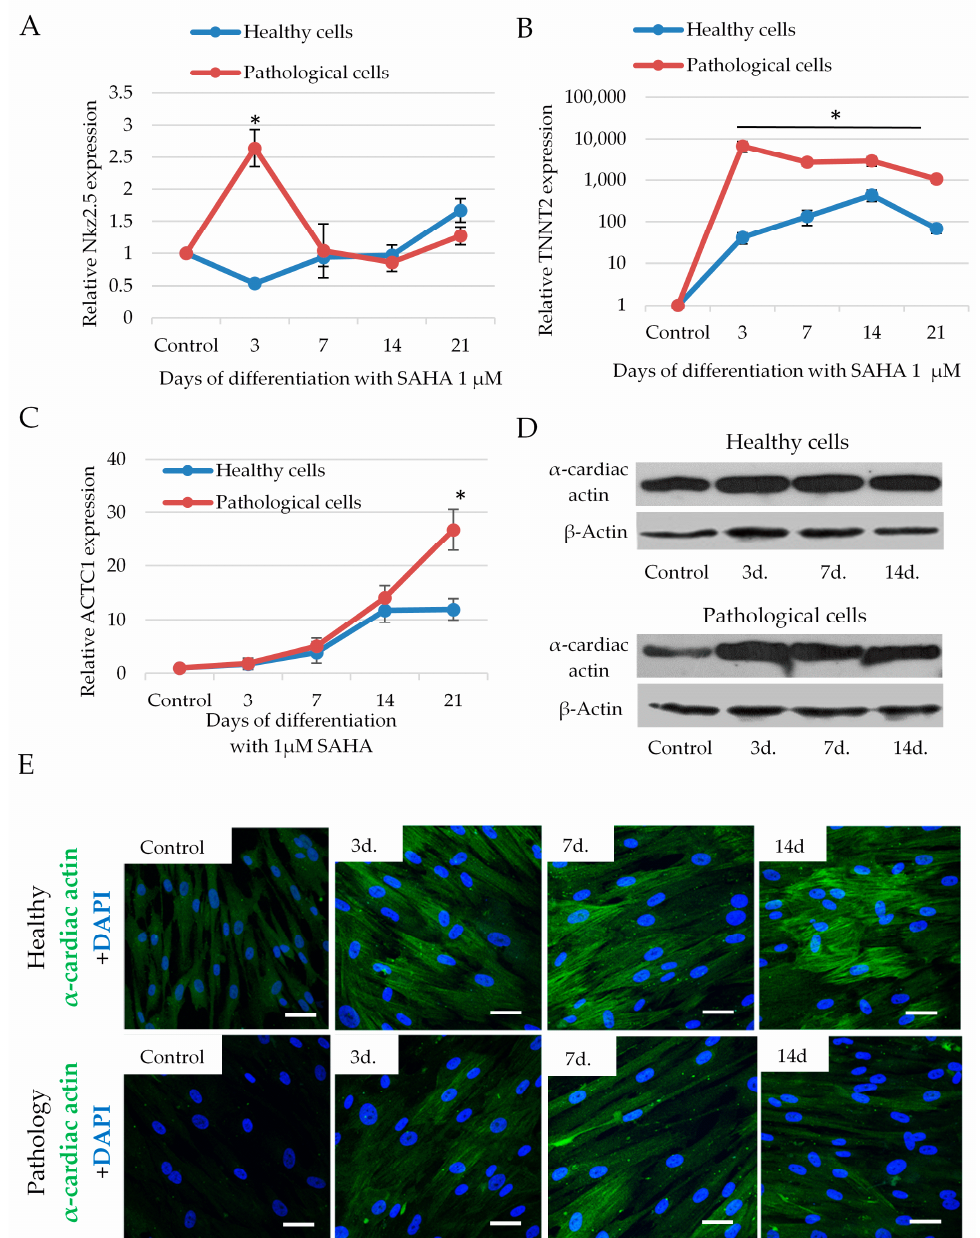
Figure 7. The impact of SAHA on the levels of transcription factor NK2 Homeobox 5 ( Nkx2.5 ), cardiac troponin T ( TNNT2 ) and alpha cardiac actin ( ACTC1 ), in healthy and pathological hmMSC. ( A ) Expression of Nkx2.5 gene (2 − ∆∆ CT ) in healthy and pathological cells during 3–21 days of cultivation with 1 µ M of SAHA. ( B ) Expression of TNNT2 gene (2 − ∆∆ CT ) in healthy and pathological cells during 3–21 days of cultivation with 1 µ M of SAHA. ( C ) Expression of ACTC1 gene (2 − ∆∆ CT ) in healthy and pathological cells during 3–21 days of cultivation with 1 µ M of SAHA. ( D ) Level of alpha cardiac actin protein compared to beta actin in healthy and pathological cells after exposure to 1 µ M of SAHA analyzed by Western blotting. ( E ) Immunocytochemical micrographs of alpha cardiac actin levels in healthy and pathological cells after exposure to 1 µ M of SAHA for 3–14 days, scale bar = 20 µ m. Control-healthy and pathological cells without SAHA. Gene expression was analyzed as follows: expression = 2 − ∆ Ct × 100,000, where ∆ Ct = (Ct target gene − Ct reference gene ); relative expression = 2 − ∆∆ Ct , where ∆∆ Ct is a subtraction of ∆ Ct of control cells from ∆ Ct of cells treated with SAHA. Data are shown as mean ± standard deviation (SD). The * p ≤ 0.05, n = 3 from three experiments. Student t -test was calculated by an Excel program. ( D ) and ( E )—representative blots and micrographs are